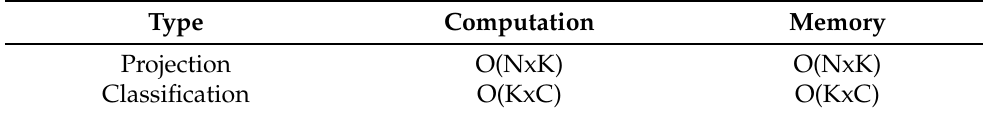
Table 2. RF eigenfingerprints